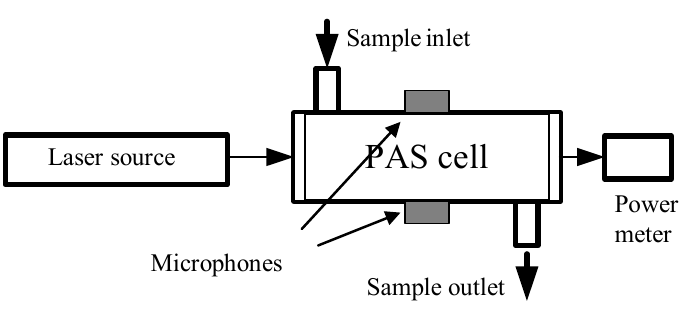
Figure 3. Schematic of photoacoustic